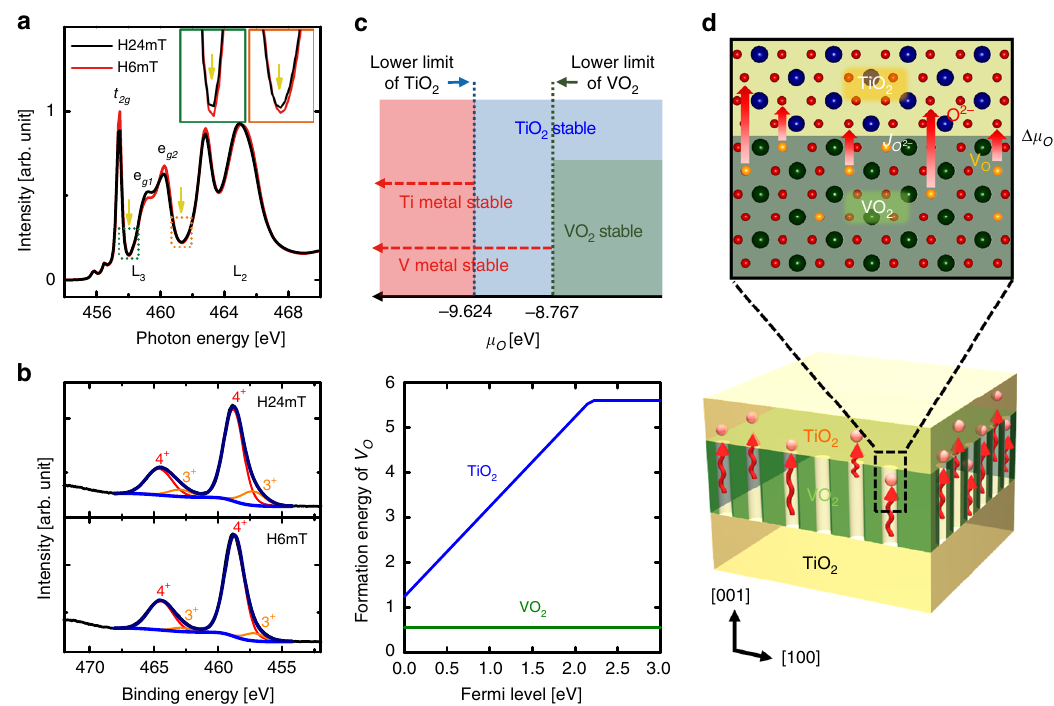
Fig. 5 Facilitated rutile TiO 2 epitaxy by Δ μ O across the TiO 2 /VO 2 interface. a Ti L -edge XAS spectra of TiO 2 grown on VO 2 templates under different pO 2 (H24mT, H6mT). The Ti L 2,3 -edge XAS signals from the H6mT were more intense and sharper than from H24mT. b XPS spectra of the Ti 2 p core level of H24mT, H6mT. negligible Ti 3 + contribution from the H6mT was observed compared to H24mT in TiO 2 /VO 2 heterostructures, which reveals the suppression of V O formation even at the surface of TiO 2 as a result of increased oxygen transport across TiO 2 /VO 2 interface under low pO 2 . Both XAS and XPS results reveal increased perfection of rutile TiO 2 fi lms after growth at low pO 2 . c First-principles density functional theory (DFT) calculations to determine values of the lower and upper limit of the chemical potential of μ O for TiO 2 and VO 2 formation. TiO 2 is the only stable compound at − 9.624eV ≤ μ O ≤ − 8.767eV. Comparison of the formation energies of V O in rutile VO 2 and TiO 2 as a function of Fermi level in the band gap of TiO 2 . d Increased thermodynamic driving force Δ μ O , assisted by high ionic kinetics k , across the interface increased the perfection of registry in the lattice of TiO 2 fi lms by increasing “ effective ” pO 2 and lowering the activation barrier for epitaxy with concurrent emergence of a metallic VO 2- δ sacri fi cial